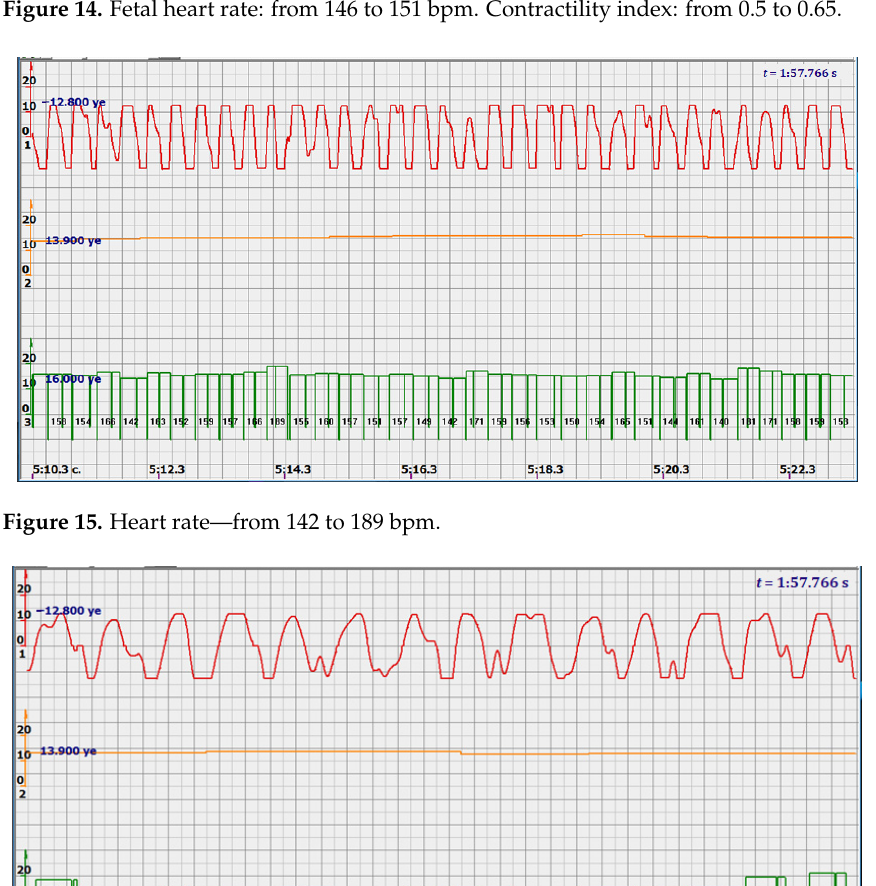
Figure 14. Fetal heart rate: from 146 to 151 bpm. Contractility index: from 0.5 to 0.65.